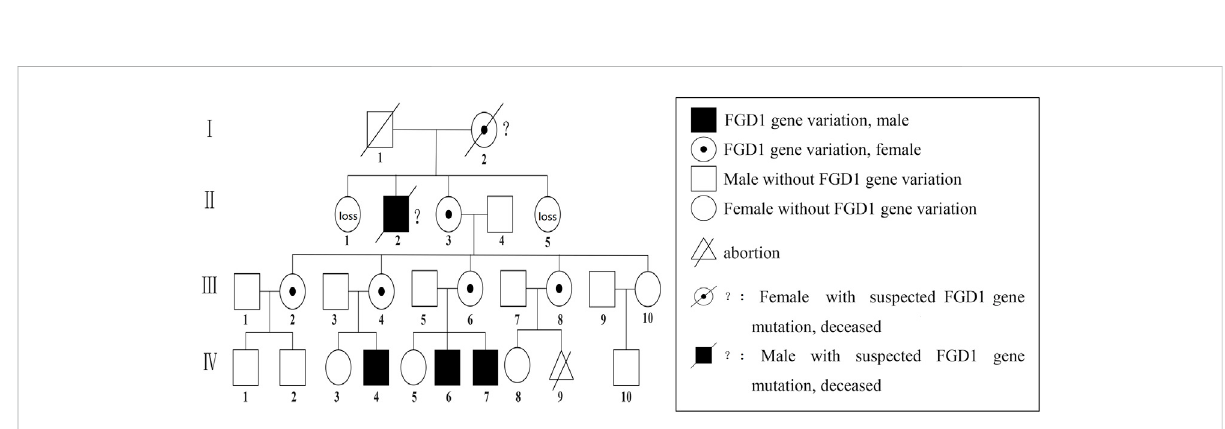
FIGURE 4 Aarskog-Scott syndrome family diagram; Ⅳ -4, Ⅳ -6, and Ⅳ -7 had FGD1 gene C.2015 + 1G > A semi-heterozygous variation, including Ⅳ -6 and Ⅳ -7 who were our patients. C.2015 + 1G > A heterozygous variation of the FGD1 gene for Ⅲ -2, Ⅲ -4, Ⅲ -6, and Ⅲ -8; Ⅰ -2 and Ⅰ -2 had died, and were speculated to have harbored FGD1 gene